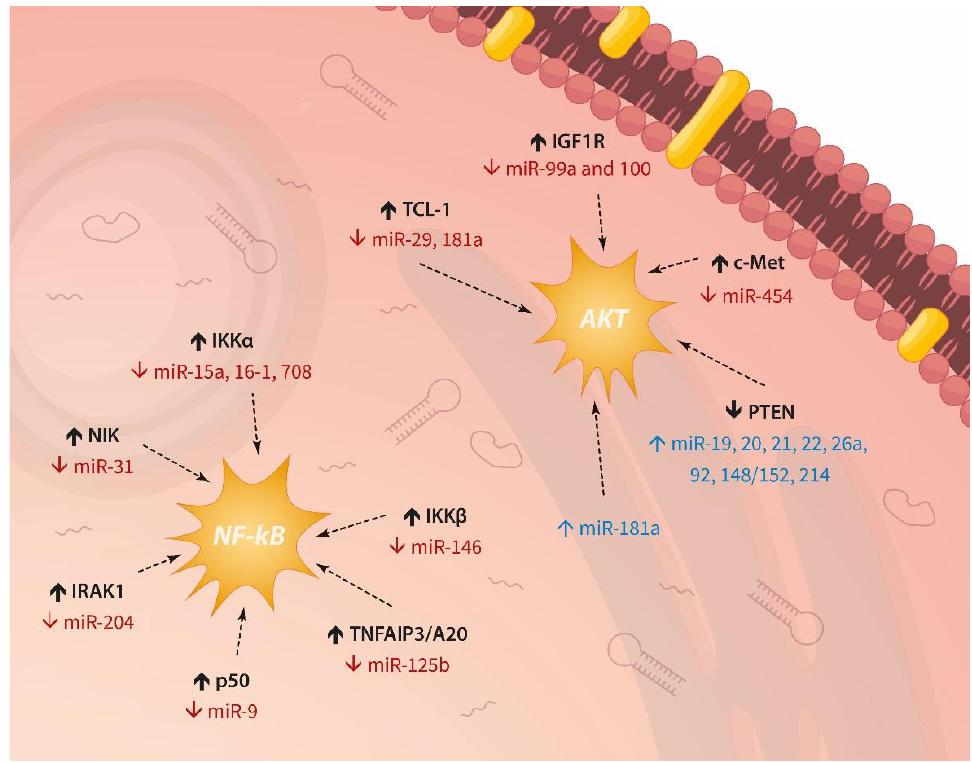
Figure 4. Recurrent miRNA-driven activation of AKT signaling and NF- κB in lymphocytic leukae- mias.